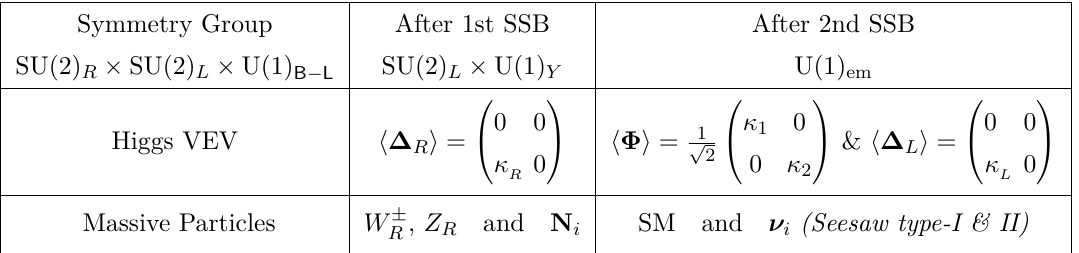
Table 3 . The spontaneous symmetry breaking structure of the minimal